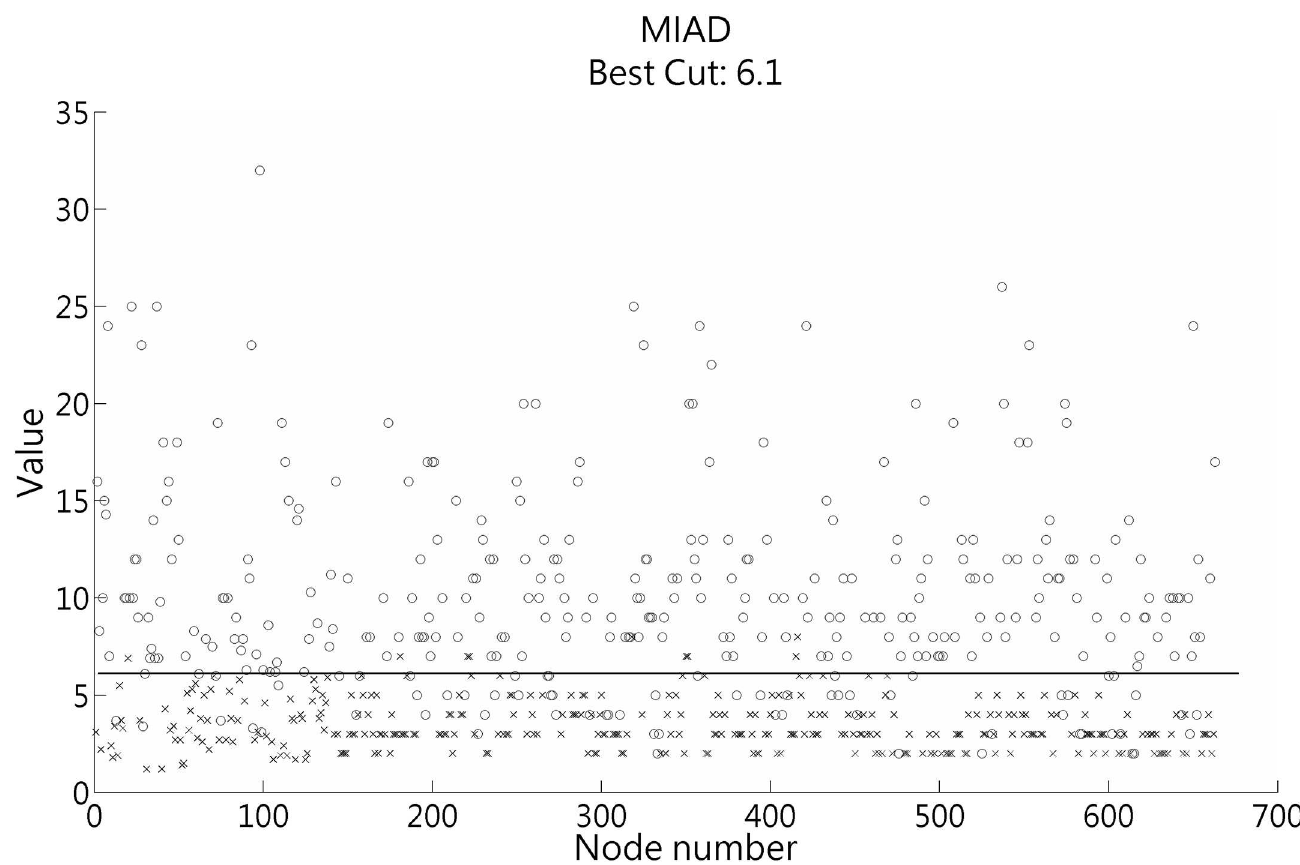
Fig 3. Scatter plots of the MIAD in stage I. Scatter plots of the minimal axial diameter (MIAD) for positive nodes ( (cid:14) ) and negative nodes ( × ) with their optimal cutoff value shown by the